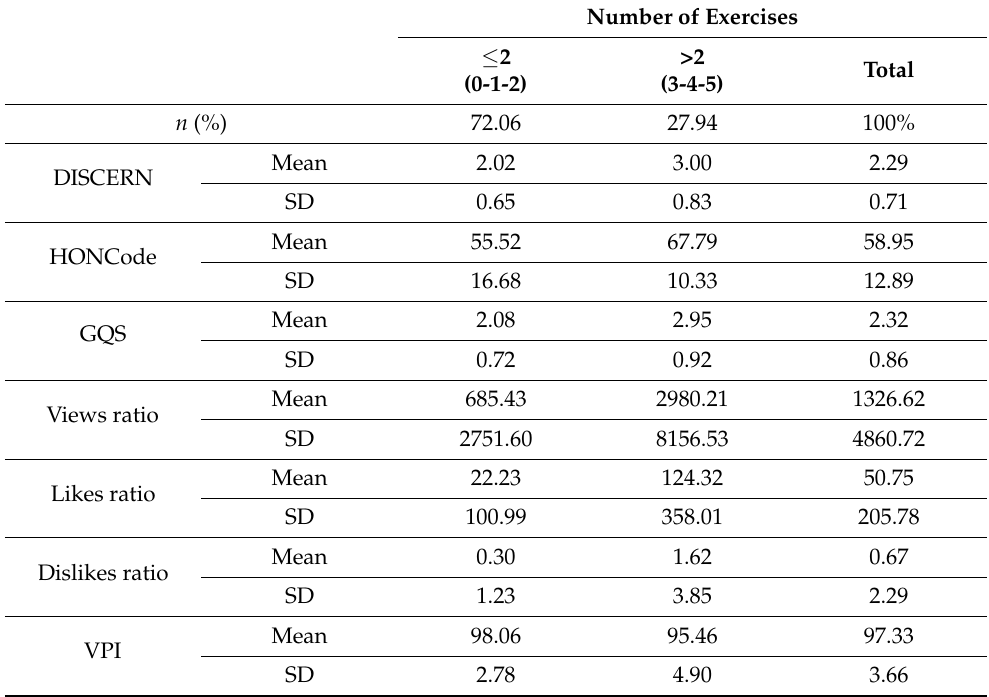
Table 4. Descriptive statistics referred to the number of exercises shown in the